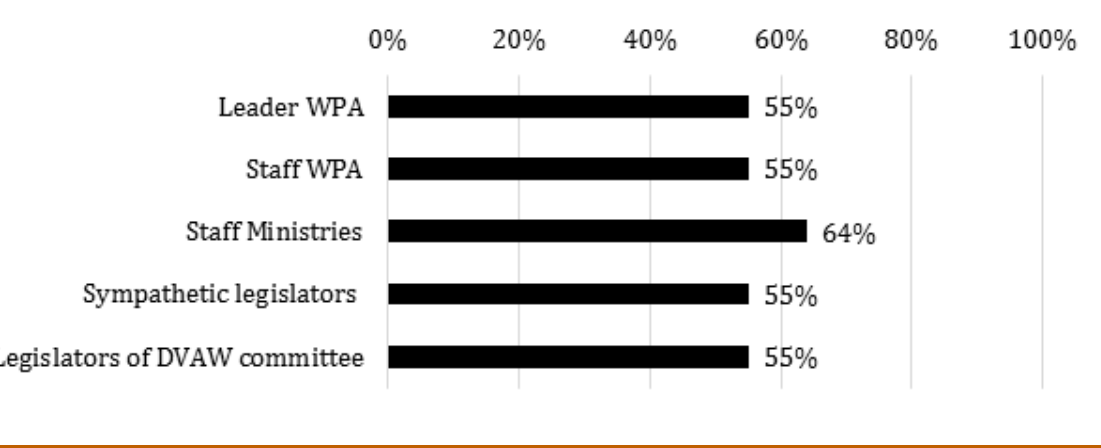
Source: Author’s own